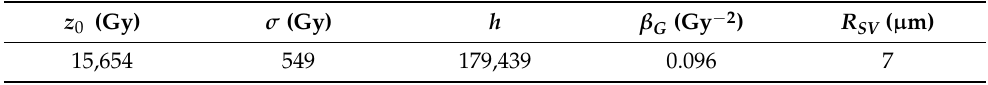
Table 1. NanOx input parameters for the HSG cell line using the LPCHEM